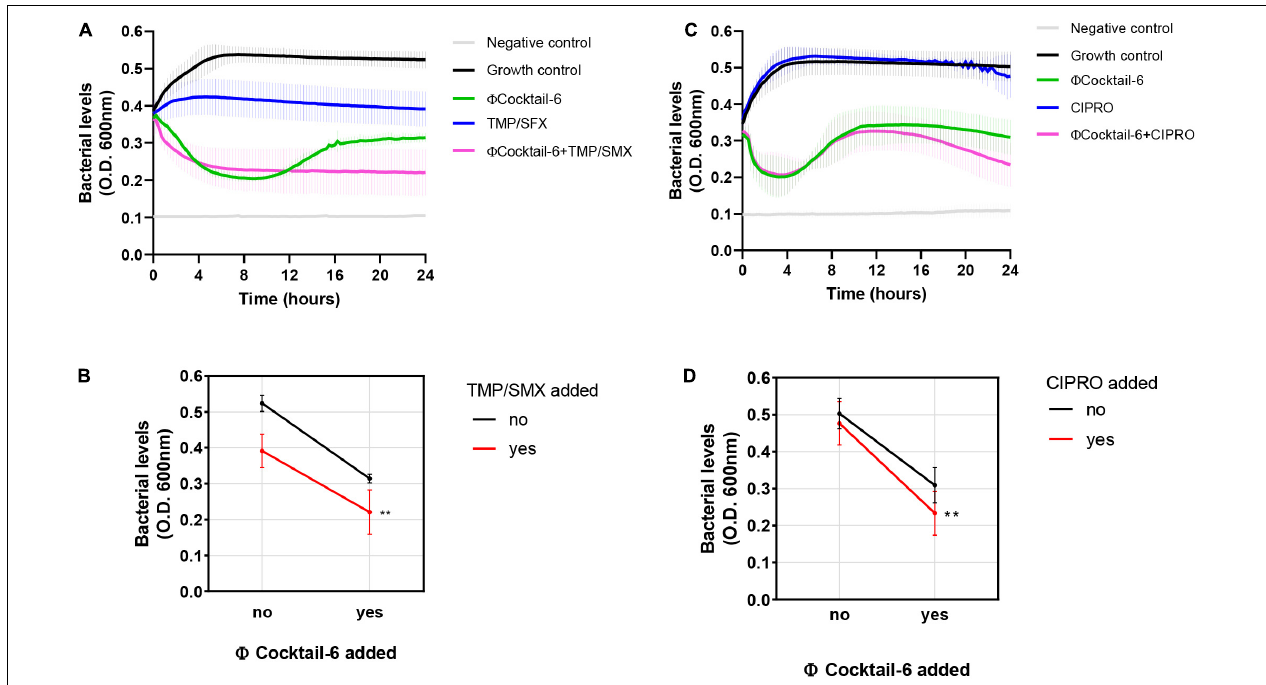
FIGURE 6 | Phage cocktail-antibiotic interactions in human urine. Bacterial growth was monitored for 24 h by measuring OD 600 in the presence of different antimicrobial combinations. Growth curves and interaction plots show additive effects of representative phage-antibiotic combinations: